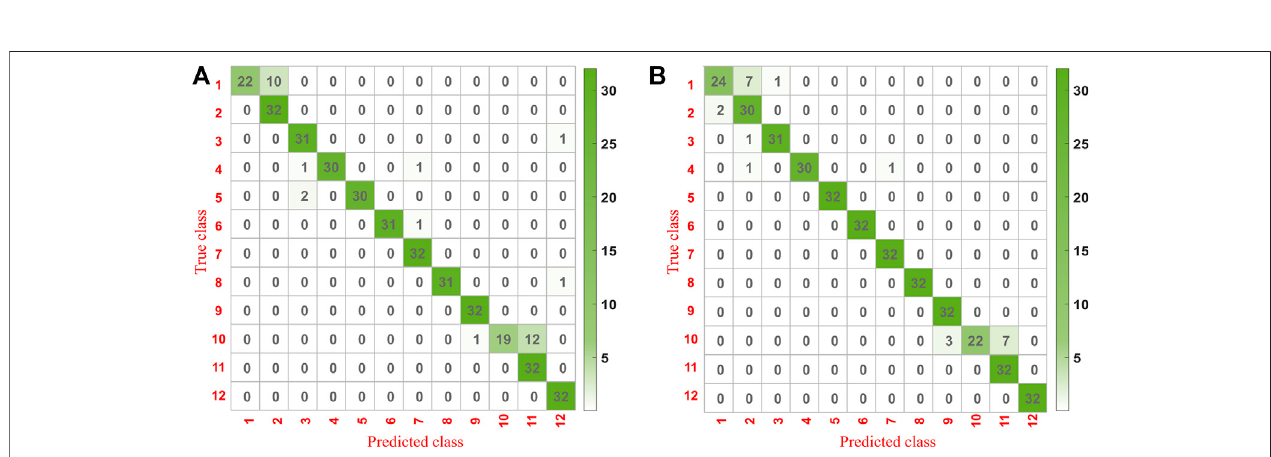
FIGURE8| Theconfusionmatrixforthepredictionsetofunderground partsof G.rigescens Franchbasedon (A) 1D-CNN1afterthesecondvariableselectionand (B) 2D-CNN with the input of spectral matrix.